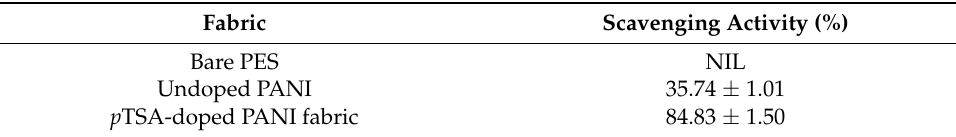
Figure 2. The antioxidant activity of bare PES fabric (control), undoped PANI fabric, and p TSA- doped PANI fabric were tested using the DPPH technique. Bars show average readings from three independent experiments. The data were analyzed using one-way ANOVA and Tukey’s hypothesis test. Error bars indicate the standard deviations. Statistical significance was indicated by **** representing p < 0.0001. Table 2. Scavenging activity of bare PES fabric (control), undoped PANI fabric, and p TSA-doped PANI fabric.